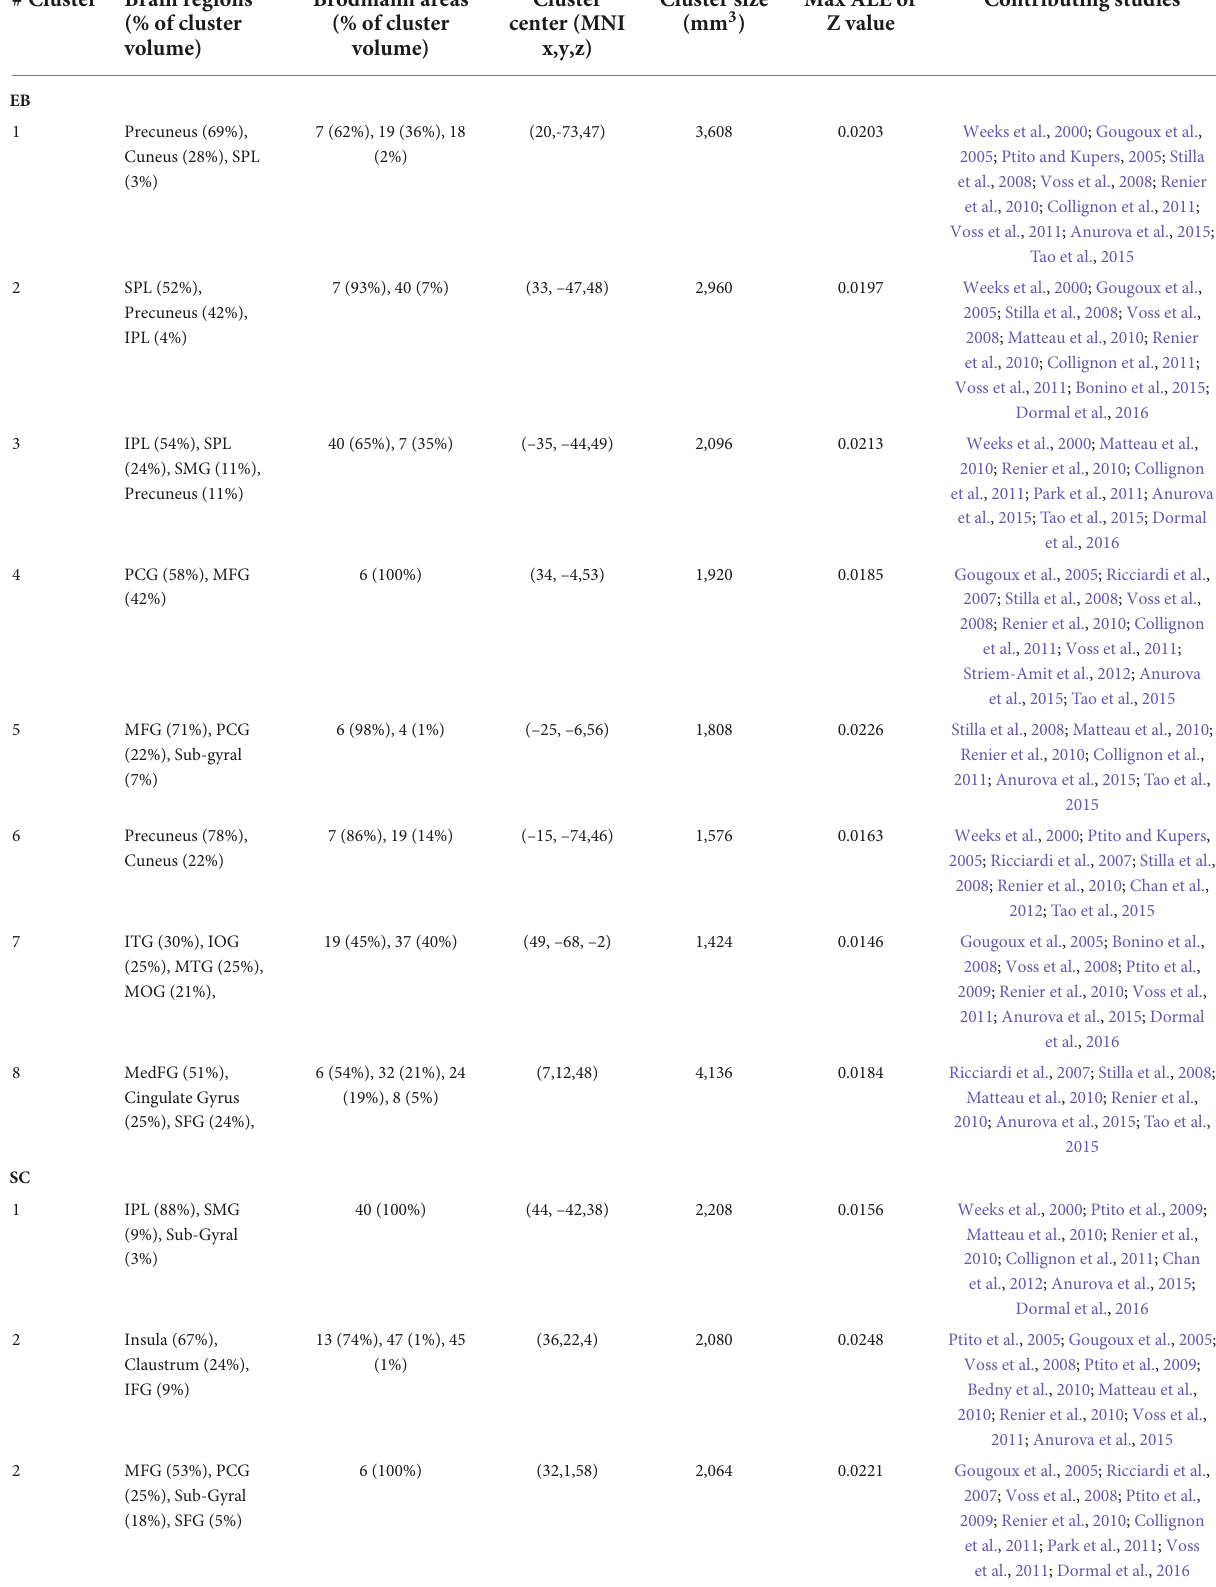
TABLE 3 Brain clusters obtained from the activation likelihood estimation (ALE) meta-analysis for spatial processing and contributing